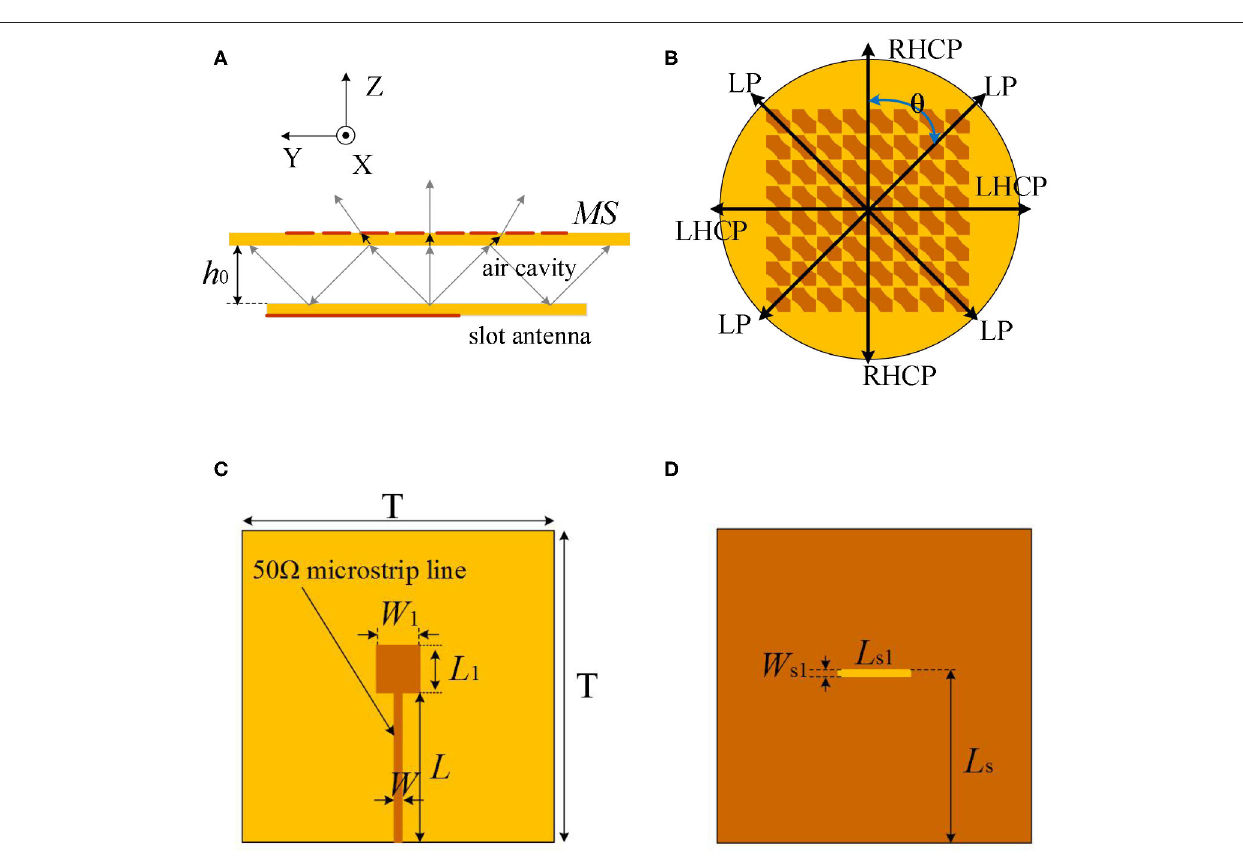
FIGURE 2 | Geometry of proposed antenna. (A) Assembly schematic, (B) Polarization of the antenna, (C) Feeder line of slot antenna, and (D) Surface of slot